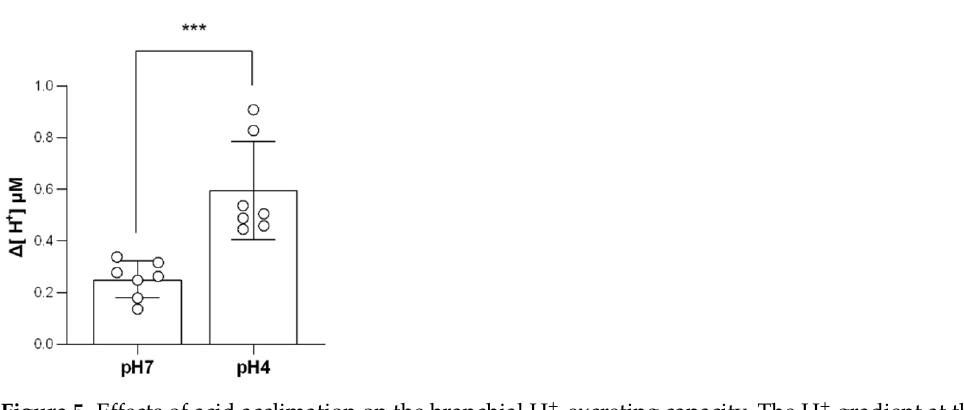
Figure 5. Effects of acid acclimation on the branchial H + -excreting capacity. The H + gradient at the gills of adult fish was measured by the SIET after 7 days of acclimation to acidic conditions. Values are the mean ± SEM (N = 7). Mann–Whitney U test, *** p < 0.001.